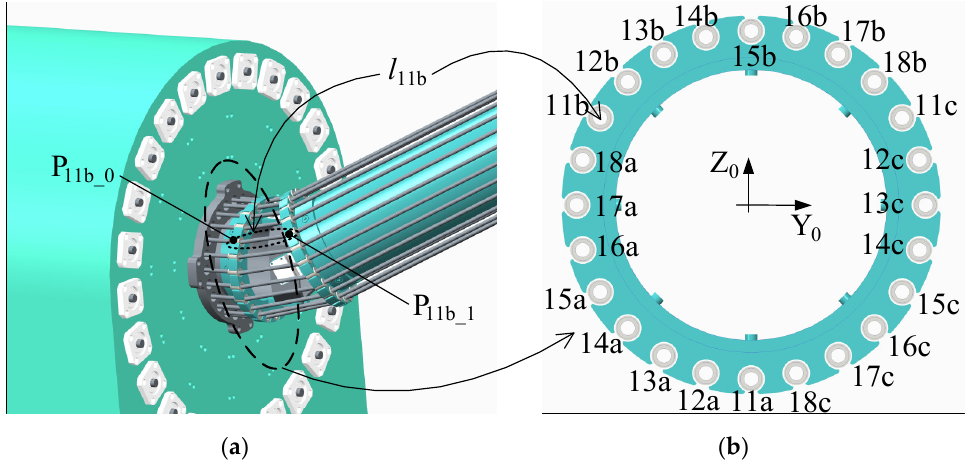
Figure 10. Schematic diagram of the distribution of ropes. ( a ) Oblique view at the first joint; ( b ) Distribution of driving cable.